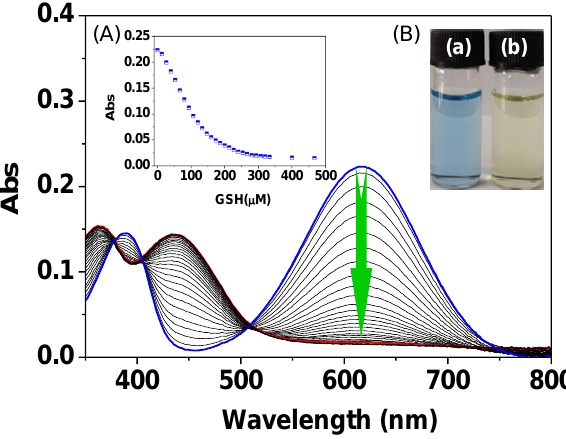
Figure 4. UV-vis absorption spectra of L-one (10 μM) in the presence of different amounts of GSH (0 –500 μM) in PBS aqueous buffer (DMF:PBS = 7:3, 20 mM, pH = 7.4). Inset: (A) Plot of the absorbance at 617 nm of L-one against the concentration of GSH; (B) Colorimetric changes of L-one in the (a) absence and (b) presence of GSH.